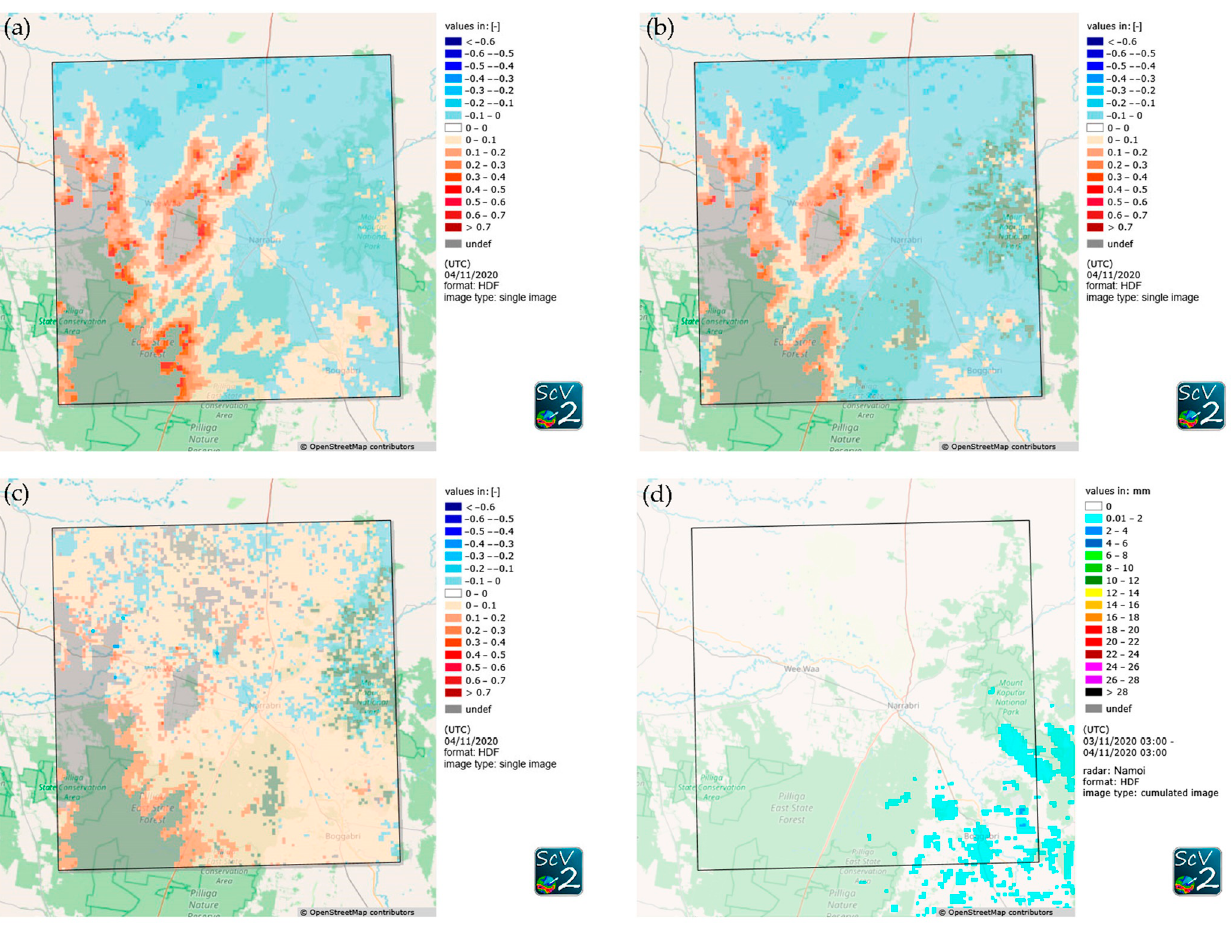
Figure 9. Relative soil moisture change (dimensionless) calculated as the difference between consecutive days of relative soil moisture for scenario 1 ( a ), for scenario 2 ( b ), and from the difference between scenario 1 and 2 ( c ) for 04/11/2022. Positive values mean an increase in soil moisture, while negative values mean a decrease in soil moisture. Additionally, the respective cumulated radar precipitation is shown ( d ).